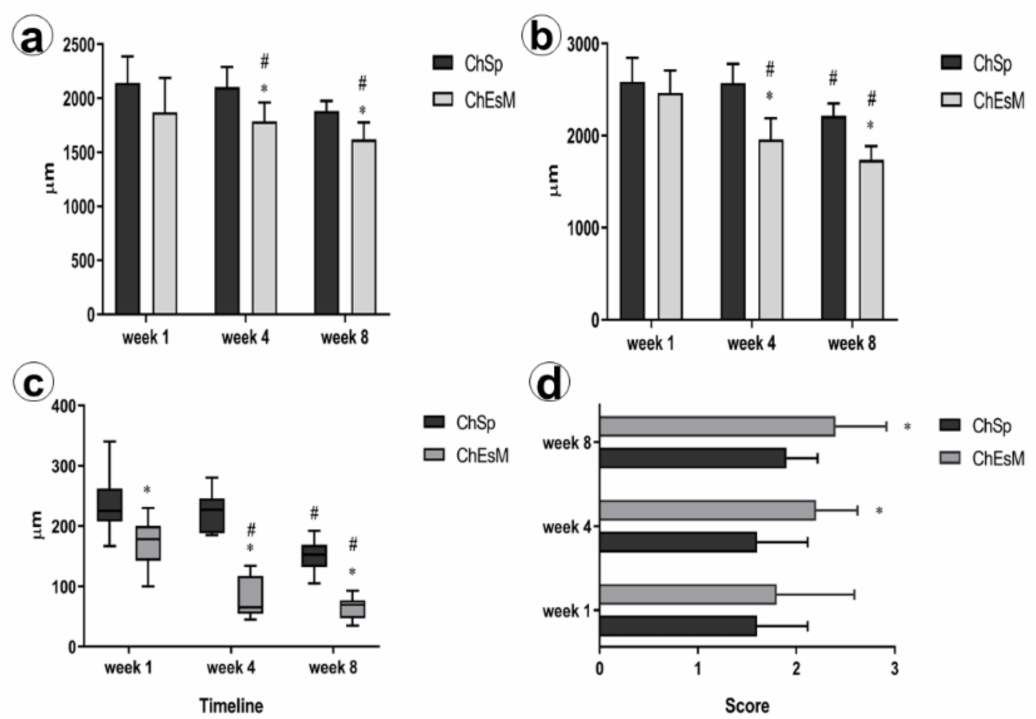
Figure 7. Dynamic changes of liver lesion size and biomaterial degradation: ( a ) shows the dynamic of hemostatic plugs and ( b ) reflects the changes in liver defect size over the time of experiment; ( c ) thickness of the capsule surrounding hemostatic materials; ( d ) host tissues ingrowth within hemostatic plug. * Shows significant differences between groups at p < 0,05; # demonstrated differences when compare with previous